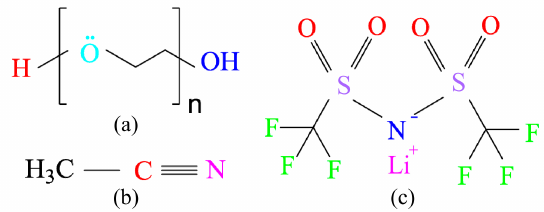
Figure 1. Structural formulas of ( a ) polyethylene oxide (PEO), ( b ) acetonitrile, and ( c ) lithium bis ((trifluoromethyl) sulfonyl) azanide